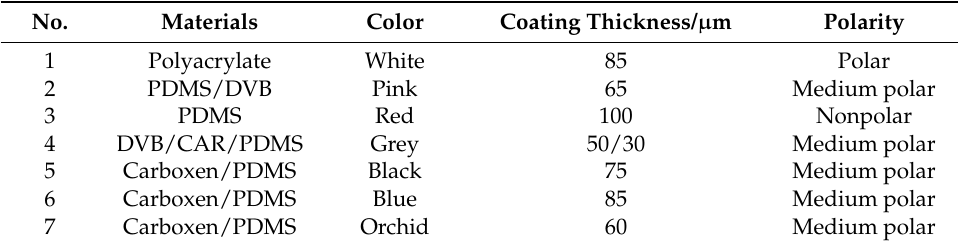
Table 4. Parameters of SPME head with different